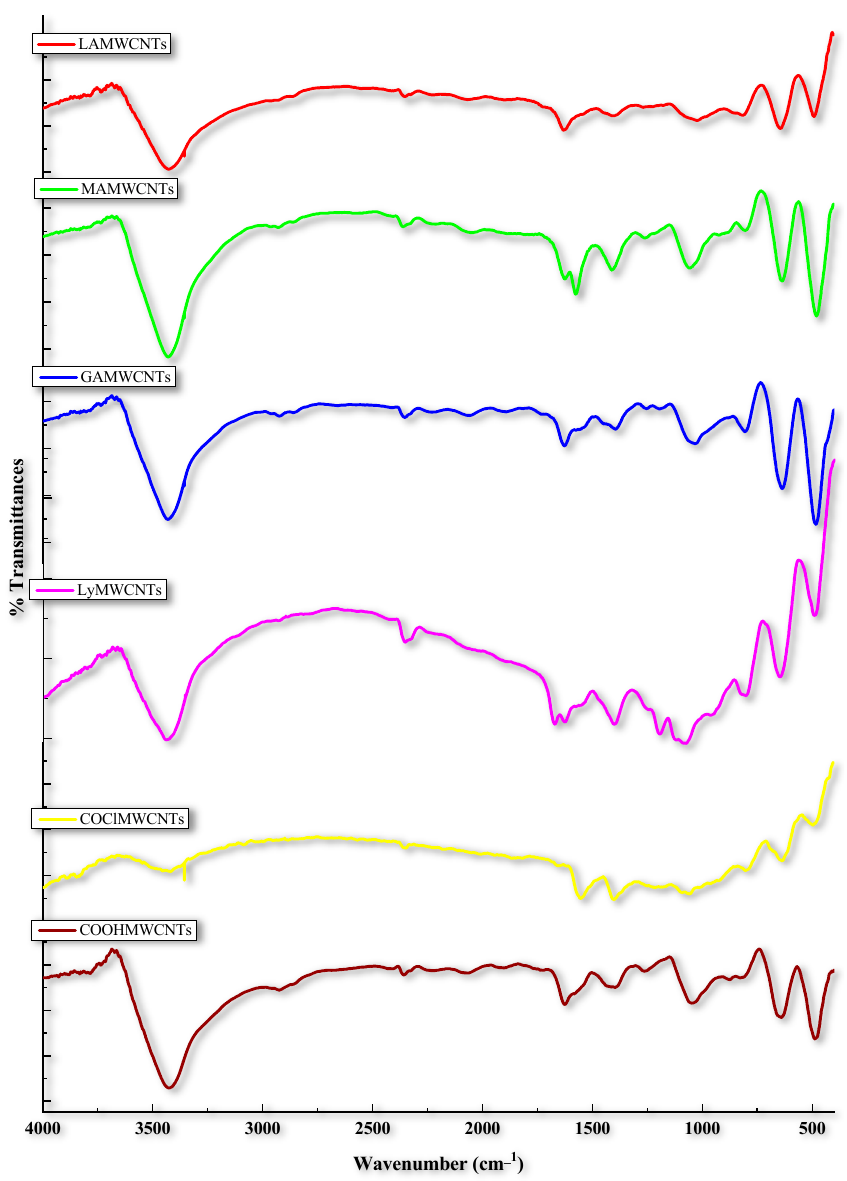
Figure 3. FT-IR spectra of the different functionalization of MWCNTs COOHMWCNTs, COClMWCNTs, LyMWCNTs, GAMWCNTs, MAMWCNTs and LAMWCNTs.